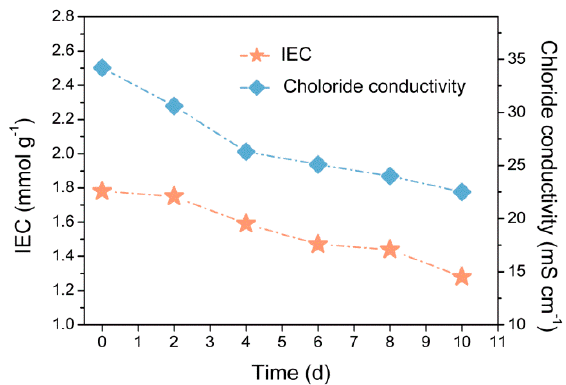
Figure 7. Time courses of chloride conductivity and IEC values of membrane C-HBM-1.78, in 1 mol L − 1 NaOH aqueous solution at 60 ◦ C. The membrane sample was converted into chloride form before conductivity measurement to avoid the influence of atmosphere CO 2 .